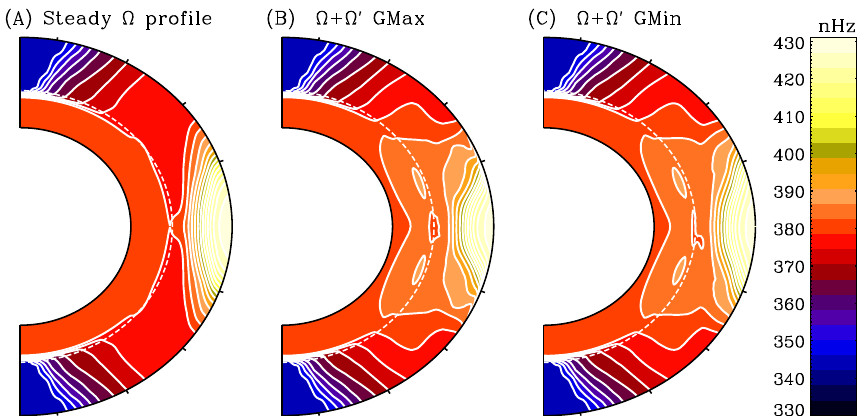
Fig. 1. (A) Steady angular velocity component (see Eq. (8)) as extracted from a hydrodynamical EULAG simulation, plotted as isocontours of rotational frequency. (B) and (C) Total angular velocity at epoch of Grand Maximum and Minimum, respectively, as produced by our non- kinematic a 2 X mean- fi eld dynamo model (speci fi cally, simulation 4 in Table 1). The interface between the convection zone and underlying radiative zone is indicated by the white